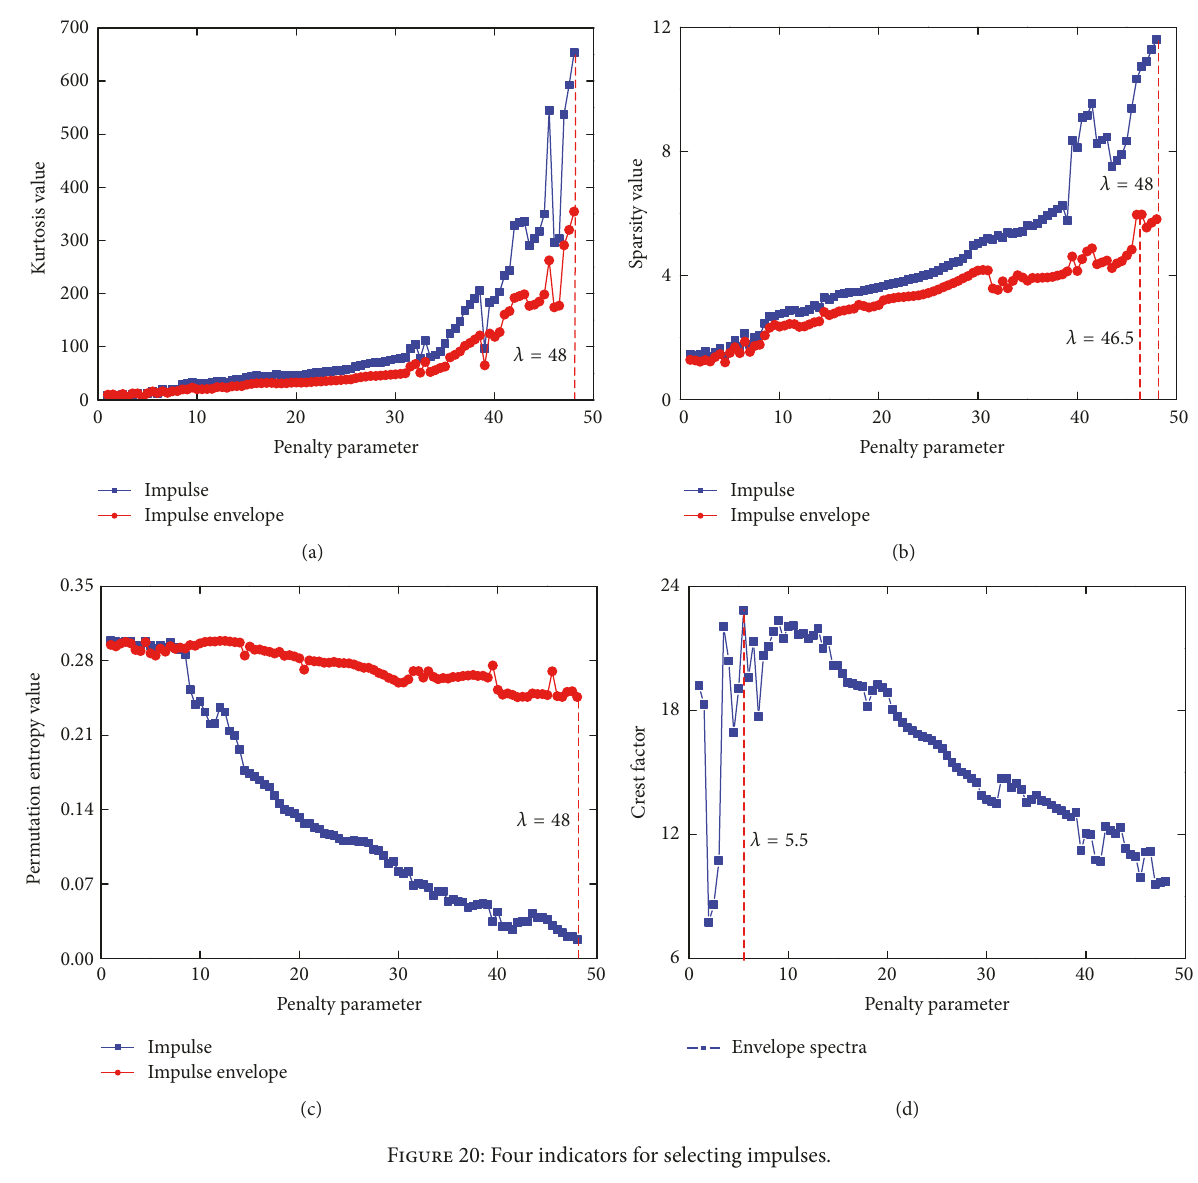
Figure 20: Four indicators for selecting impulses.